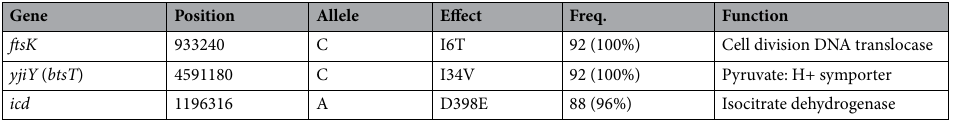
Table 2. Core non-synonymous mutations among positively selected genes (Frequency > 95%). Freq. refers to the frequency of mutations among our 92 samples.